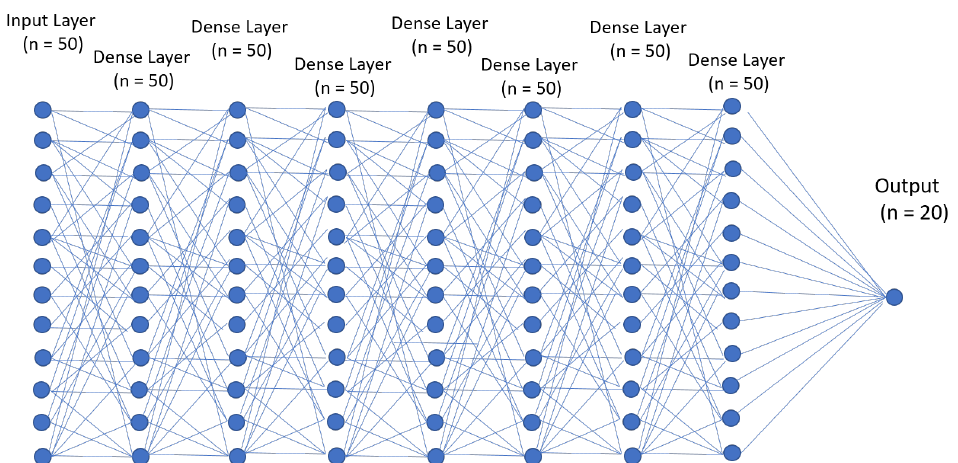
Figure 10. Graphic representation of the FNN configuration, chosen after the optimization process, with a total of 7 dense hidden layers.